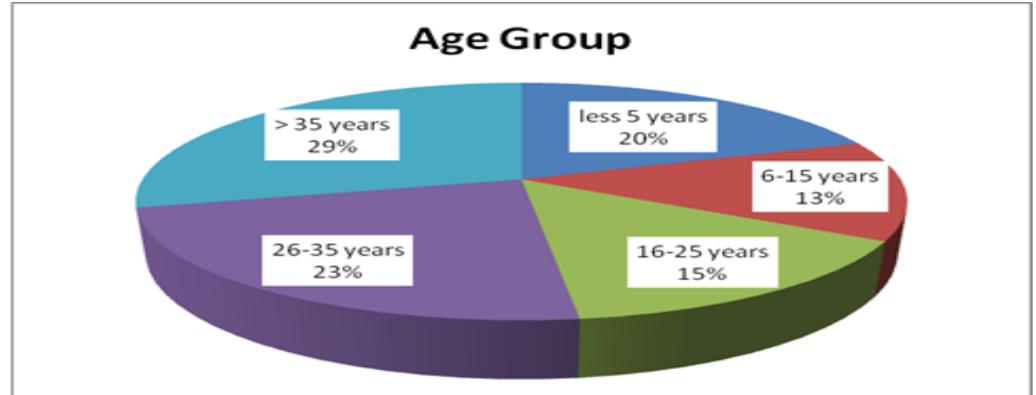
Figure 3. Distribution of samples collected according to age